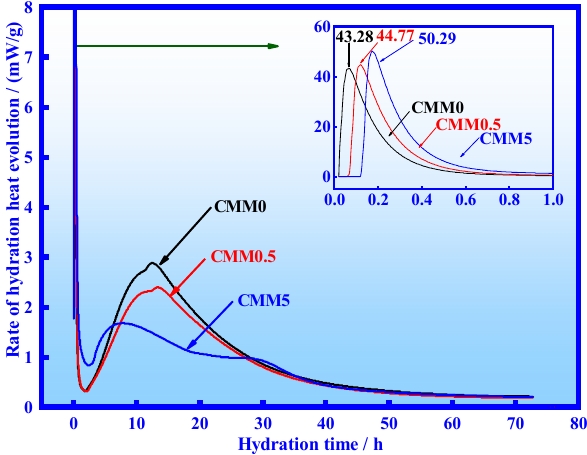
Figure 7. CMM hydration heat evolution rate within 72 h.